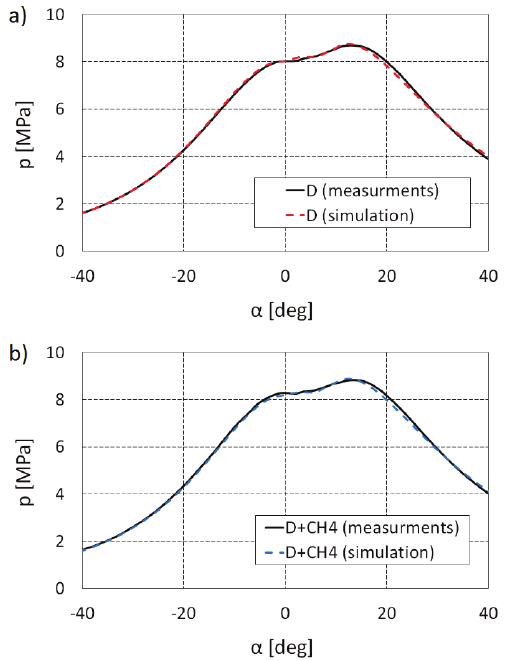
Fig. 4. Comparison of the pressure simulated and measured empirically (engine speed 1800 rpm, maximum load) for two cases of engine supply: a) with diesel oil – D, b) with a mixture of diesel oil and 30% (w/w) of methane – D + CH4